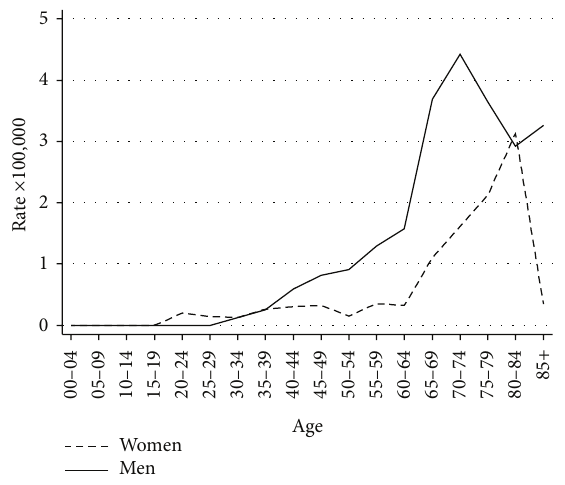
Figure 1: Age-specific sinonasal cancer rates ( × 100,000 person- years) by gender; Lombardy sinonasal cancer registry,